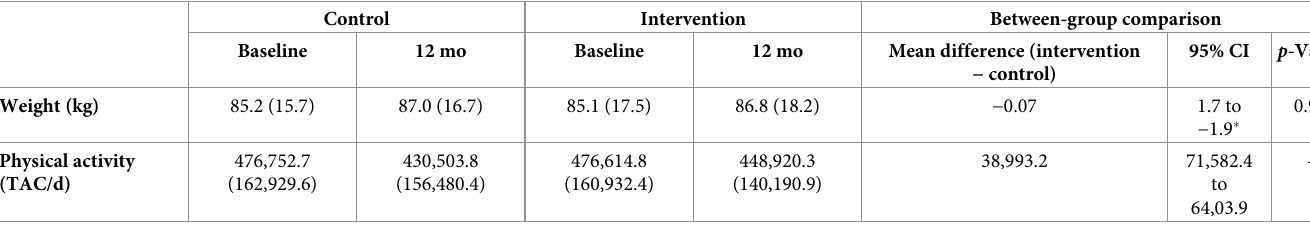
Table 2. Weight and physical activity outcomes at baseline and 12